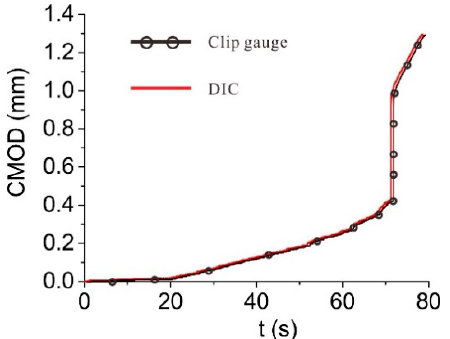
Figure 4. Comparison of the crack mouth opening displacements (CMOD) measured by the digital image correlation (DIC) technique and the clip gauge.